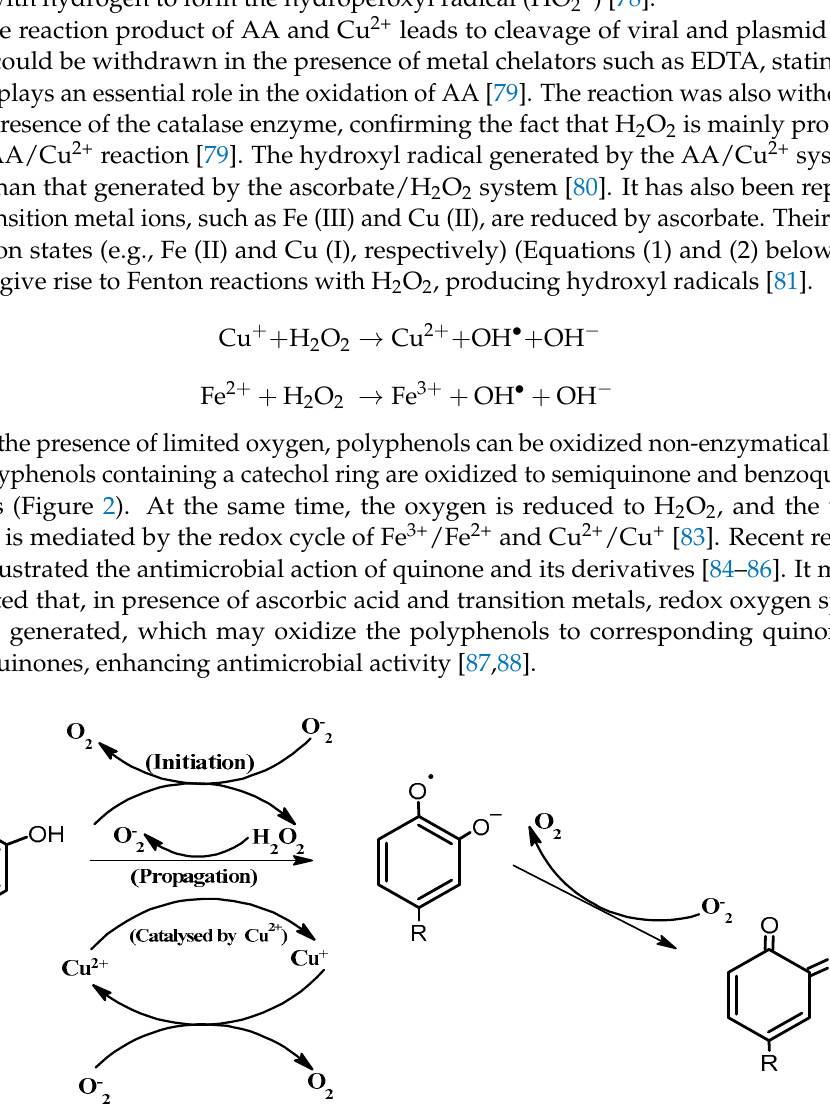
Figure 2. The figure illustrates the oxidation of the catechol ring containing polyphenols, which is oxidized to benzoquinone radical with an intermediate formation of semiquinone in presence of Cu 2+ catalyst. The reaction starts with the initiation step of O 2 being converted to O 2 − , followed by a propagation step during which O 2 − is converted to H 2 O 2 [89]. Phenolics from plants have been combined with other substances, sometimes referred to as adjuncts, such as transition metal ions or vitamin C to enhance phenolic efficacy [90,91]. Enhancement of antimicrobial activity was observed in the case of pomegranate rind Ext by Cu (II) alone or with both Cu (II) and AA combinations against many bacterial strains [92,93]. The addition of copper (II) sulfate and AA ascertained the enhancement of antimicrobial activities of whole and sub-fractionated white tea against S. aureus [94]. Enhanced antimicrobial activity against S. aureus and E. coli was also observed by the addition of the AA to the (+)-catechin–copper (II) mixture [95]. A recent study